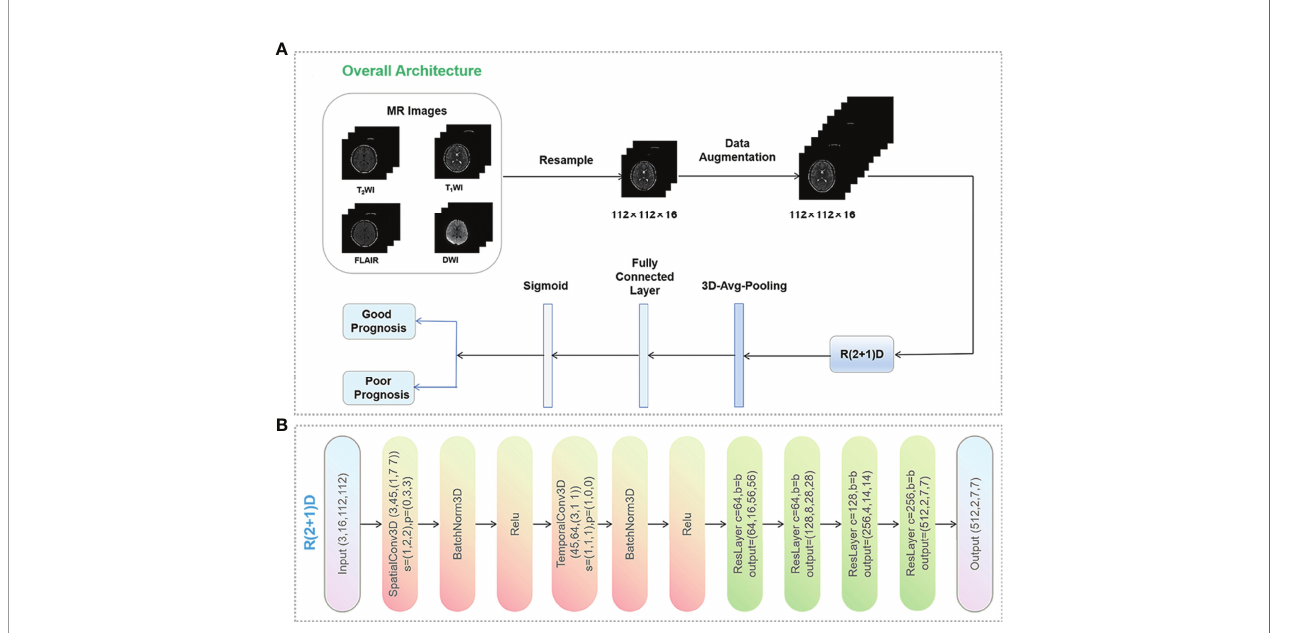
FIGURE 1 | Data preprocessing pipeline. (A) Data preprocessing process and the work fl ow of the deep learning model. Data augmentation was performed only in the training set, including random reduction, center reduction, random fl ipping and brightness adjustment. (B) Overall architecture of R(2 + 1)D network. C, s, p, and b represent the number of input channels, the step size of the 3D convolution kernel, the size of padding, and spatio-temporal Resblock module, respectively. This module is a residual network structure. In the convolution layers of layer 1, layer 3, layer 4 and layer 5 of the model, the spatio-temporal Resblock module performs down sampling. The input tensor is (C, x, y) and the output tensor is (out_channels, X/2, Y/2). In the second layer of the model, the spatio-temporal Resblock module is not downsampled, and the input and output tensor shapes are the